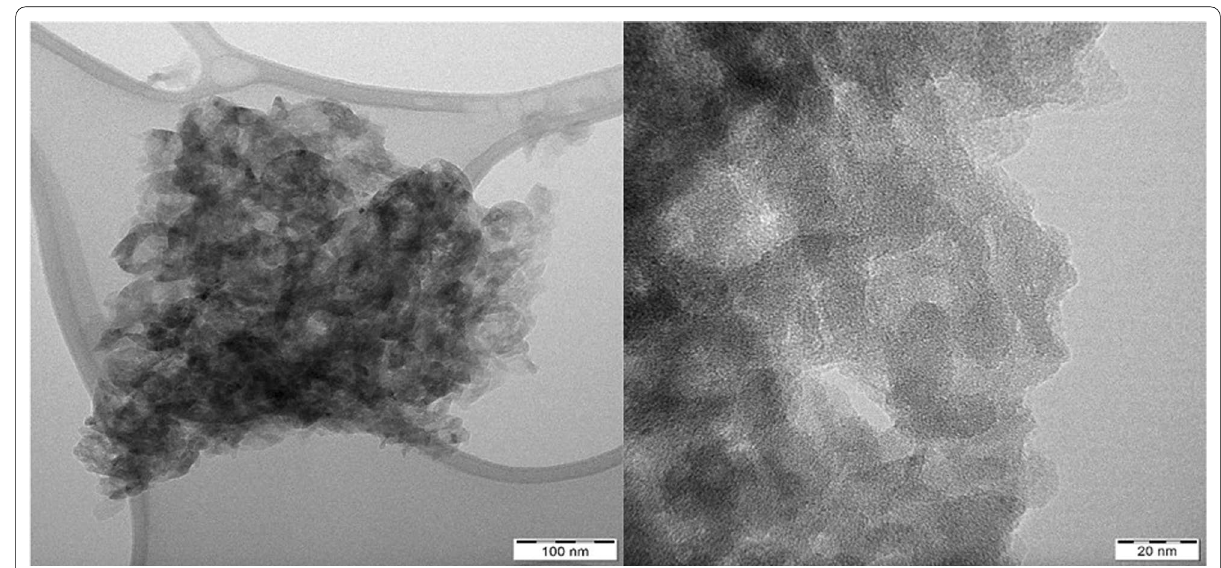
Fig. 1 TEM micrographs of AgCNE4 with different resolutions